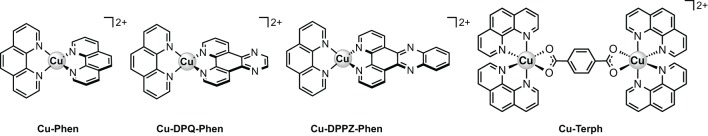
Molecular structures of the copper(II) complex cations examined in this study.